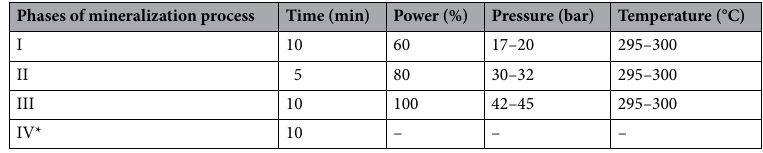
Table 2. Microwave mineralization process. *Cooling process.